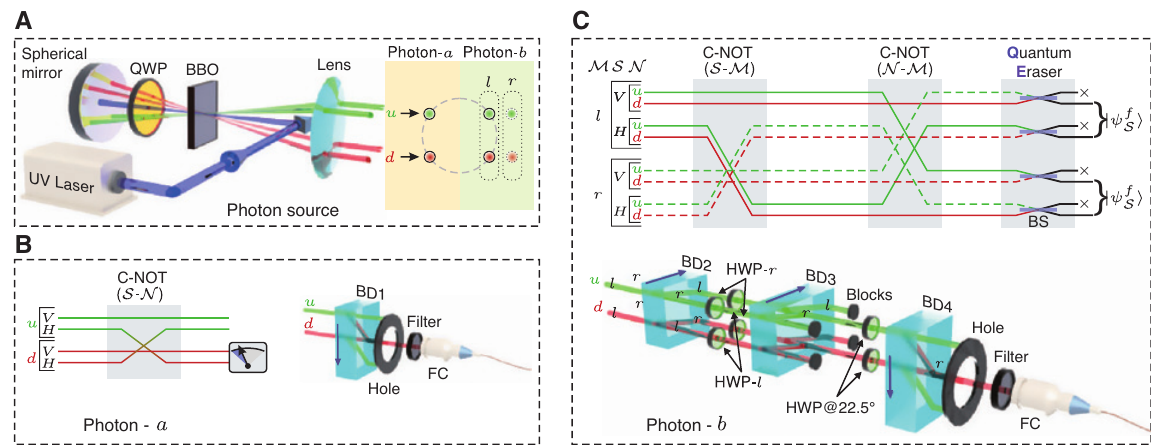
Figure 2: Experimental setup. (A) The photon source prepared in our experiment; we adopt the structure used in Ref. [34]. A vertically polarized ultraviolet (UV) laser O (BBO) crystal to generate photon pairs (selected by spectrum filters with center at (wavelength centered at 406.7 nm) pumps a β -BaB 2 4 813.4 nm and bandwidth 3 nm) in a polarization-momentum hyper-entangled state. We collect four points in the entanglement ring and denote the left part as photon- A and the right part as photon- B , respectively. For photon- B , we introduce another degree of freedom (left and right modes) to act as the meter M . (B) The operations on Alice’s side. The left part schematically illustrates the quantum circuit. A beam displacer (BD1) with its optical axis cut in the vertical plane, which transmits vertically polarized light straightly and displaces horizontally polarized light in the vertical plane, is used to realize the C-NOT gate (polarization control path). The hole helps us to collect the photons in path- d by a fiber coupler (FC) after a spectrum filter. The operations by Bob are shown in (C) which includes the schematic diagram in the upper panel and experimental realizations in the lower panel. The C-NOT gate between system and meter is realized by BD2 (horizontally cut), where vertically polarized photons propagate directly and horizontally polarized photons are shifted in the horizontal plane. Four half wave plates (HWPs) collaborate with another horizontally cut BD3 to arrange that the two l ( r ) beams (green and red) lie in the same vertical plane. Two HWPs with their optical axes oriented at 22.5 ° collaborate with a vertically cut BD4 to realize the quantum eraser, which erases the quantum information encoded in the ancilla N . QWP stands for quarter wave plate at 813.4